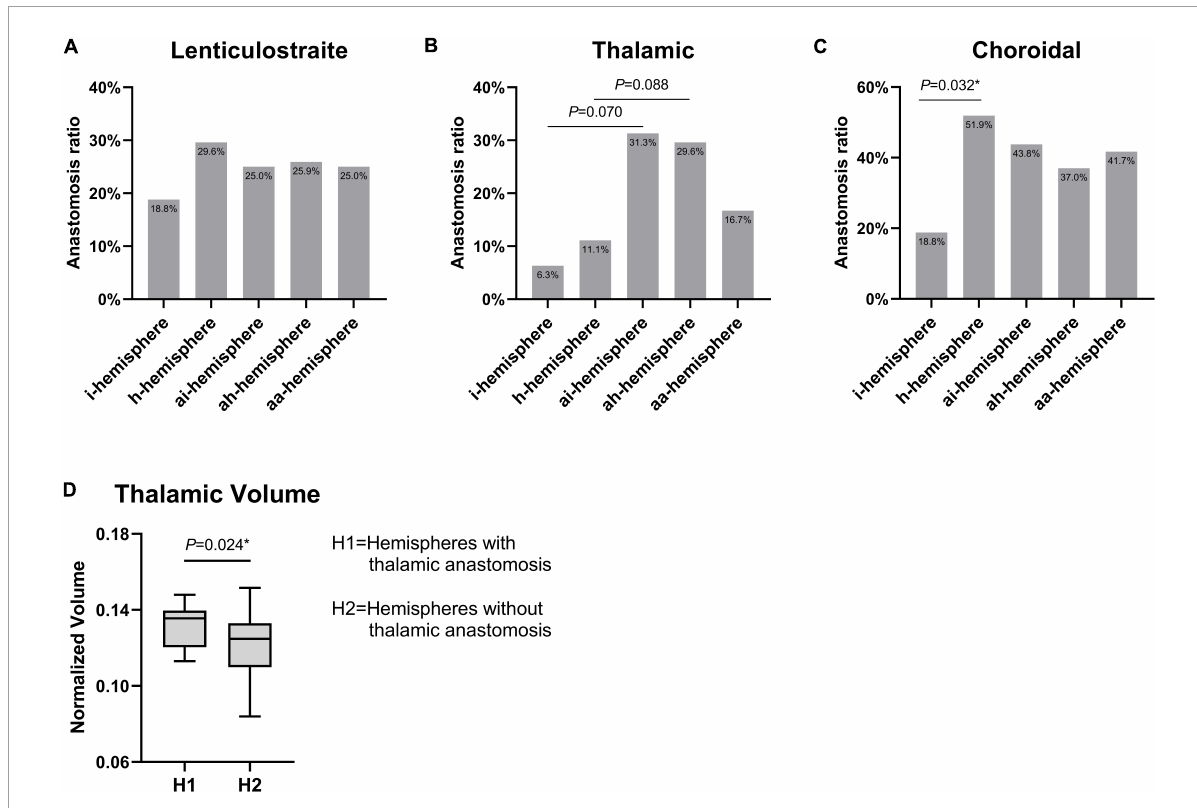
FIGURE4 (A–C) Comparison of three types of collateral features among different hemispheres in moyamoya disease (MMD). (D) The difference of thalamic volume between hemispheres with thalamic anastomosis and those without thalamic anastomosis. * P < 0.05.